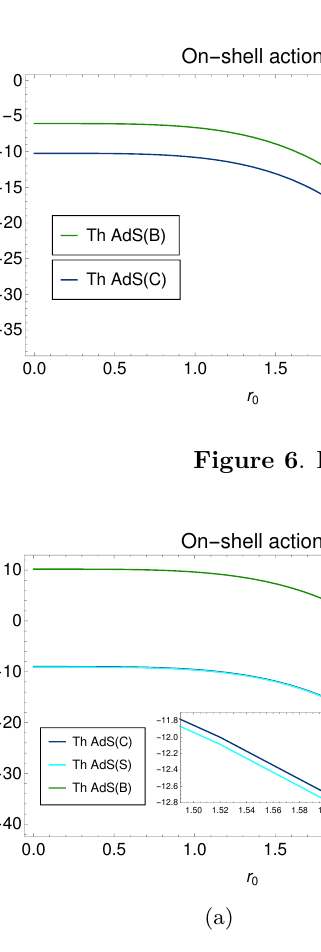
Figure 7 . Energies of various branes: b = 0 . 5 , m q = 2 . 7